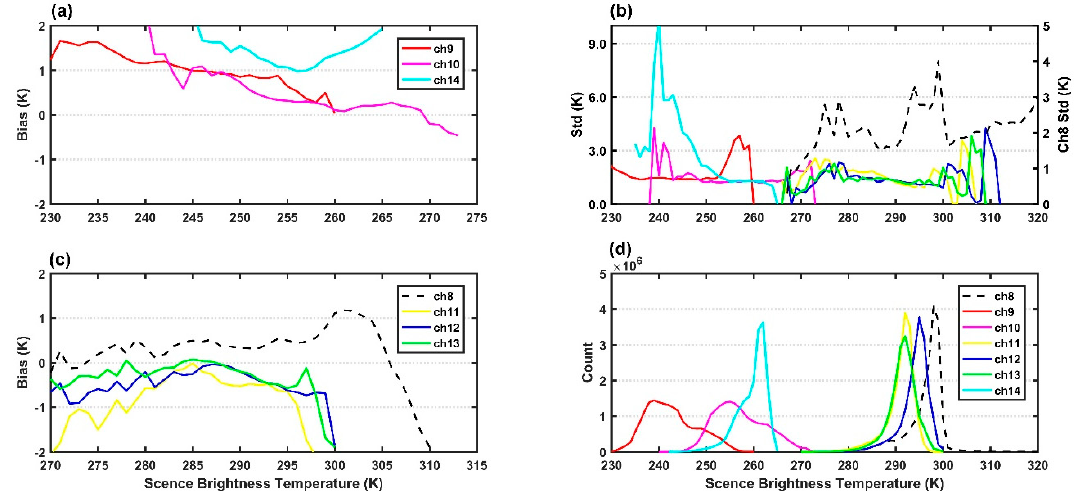
Figure 10. The dependence of ( a , c ) biases, ( b ) standard deviation and ( d ) count on scene brightness temperature (units: K) at 1 K intervals for AGRI data for channels 8–14 over ocean.